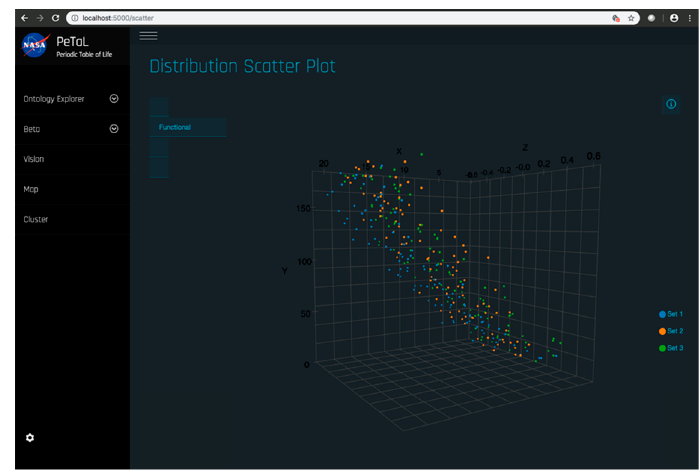
Figure 35. Distribution scatter plot displaying semi-random generated data points.